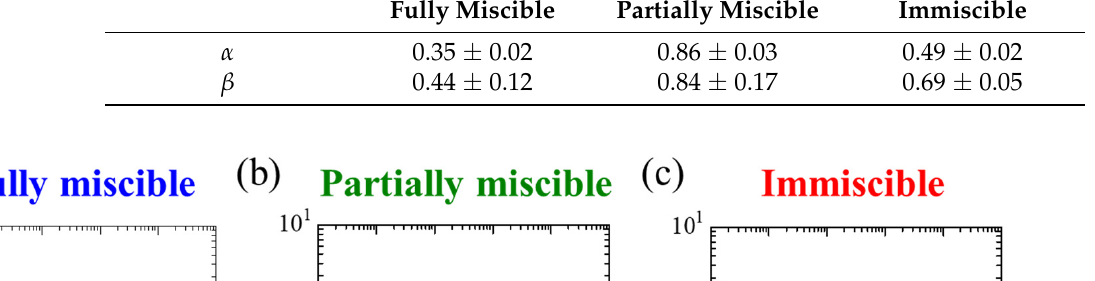
Figure 6. Time evolution of the overall width W ( t ) . The various colors indicate different miscibilities, and the dashed lines serve as visual guides. The slope is calculated at the region where the value of α is constant. Table 2. Summary of steady values of α and β for the three experiments.